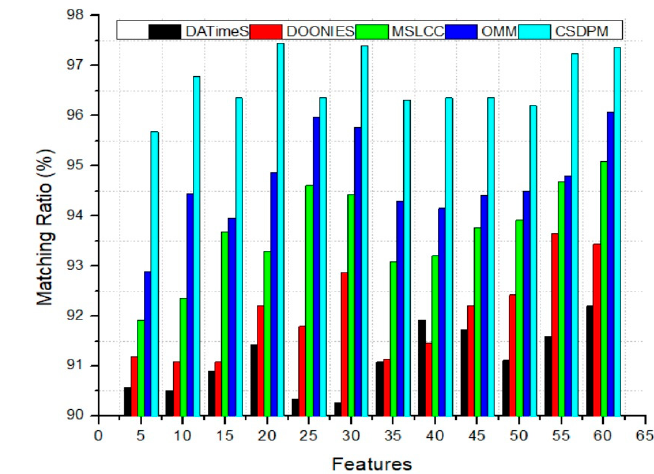
Figure 15. Matching ratio.